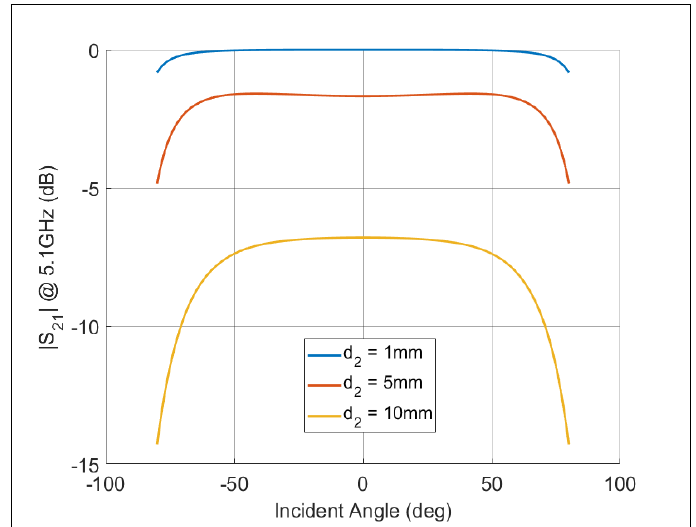
Figure 17. Attenuation due to the incident angle as the plasma thickness, d 2 , is